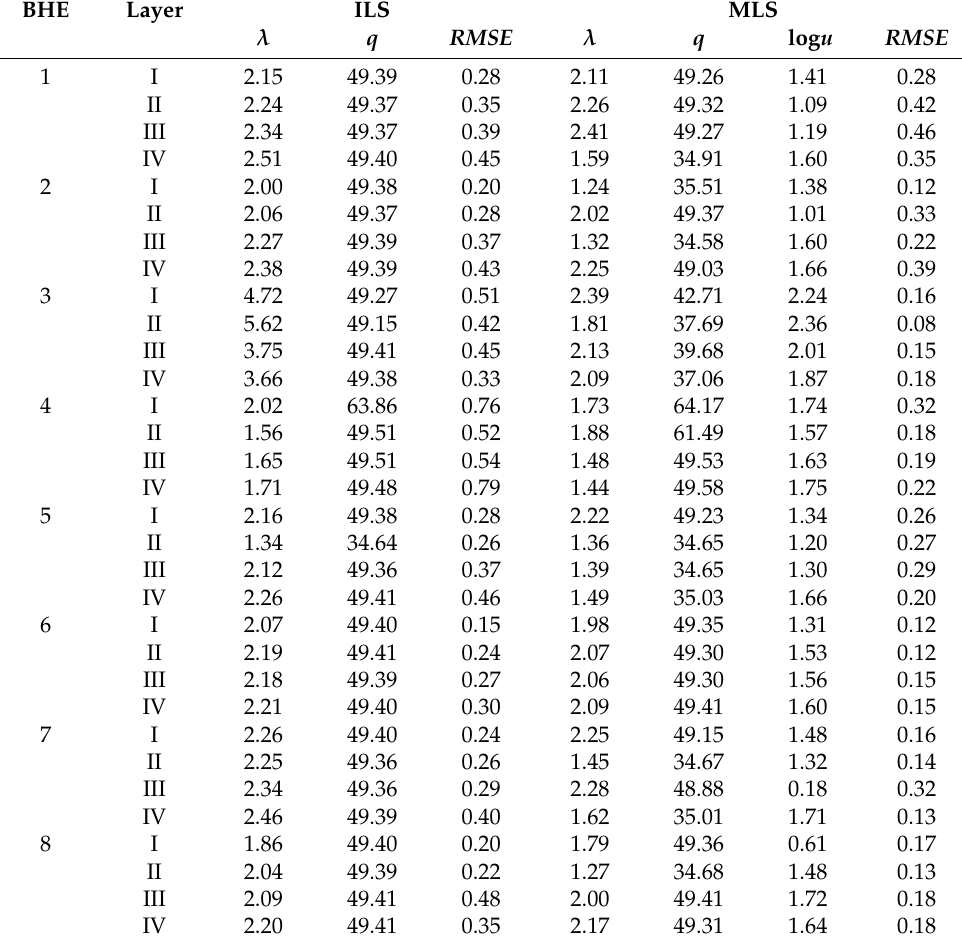
Table 2. Summary of history matching analysis